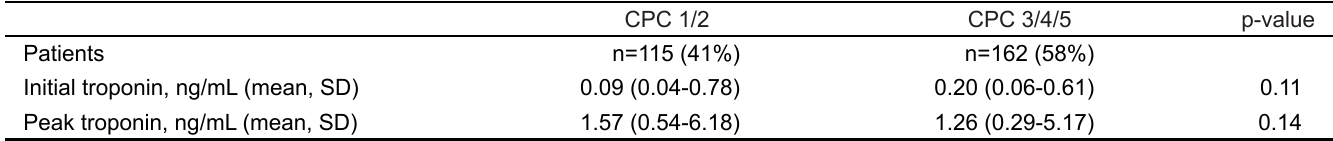
Table 5. Association of initial and peak troponin with neurologic